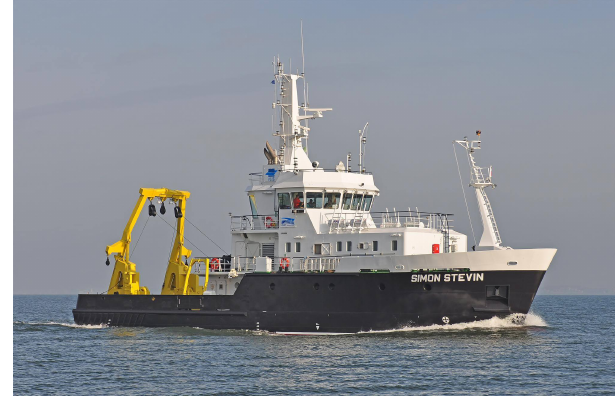
Figure 5. Research vessel Simon Stevin , courtesy of the Flemish Institute of the Sea (W.A.T.E.R. 2016 and W.A.T.E.R. 2017).